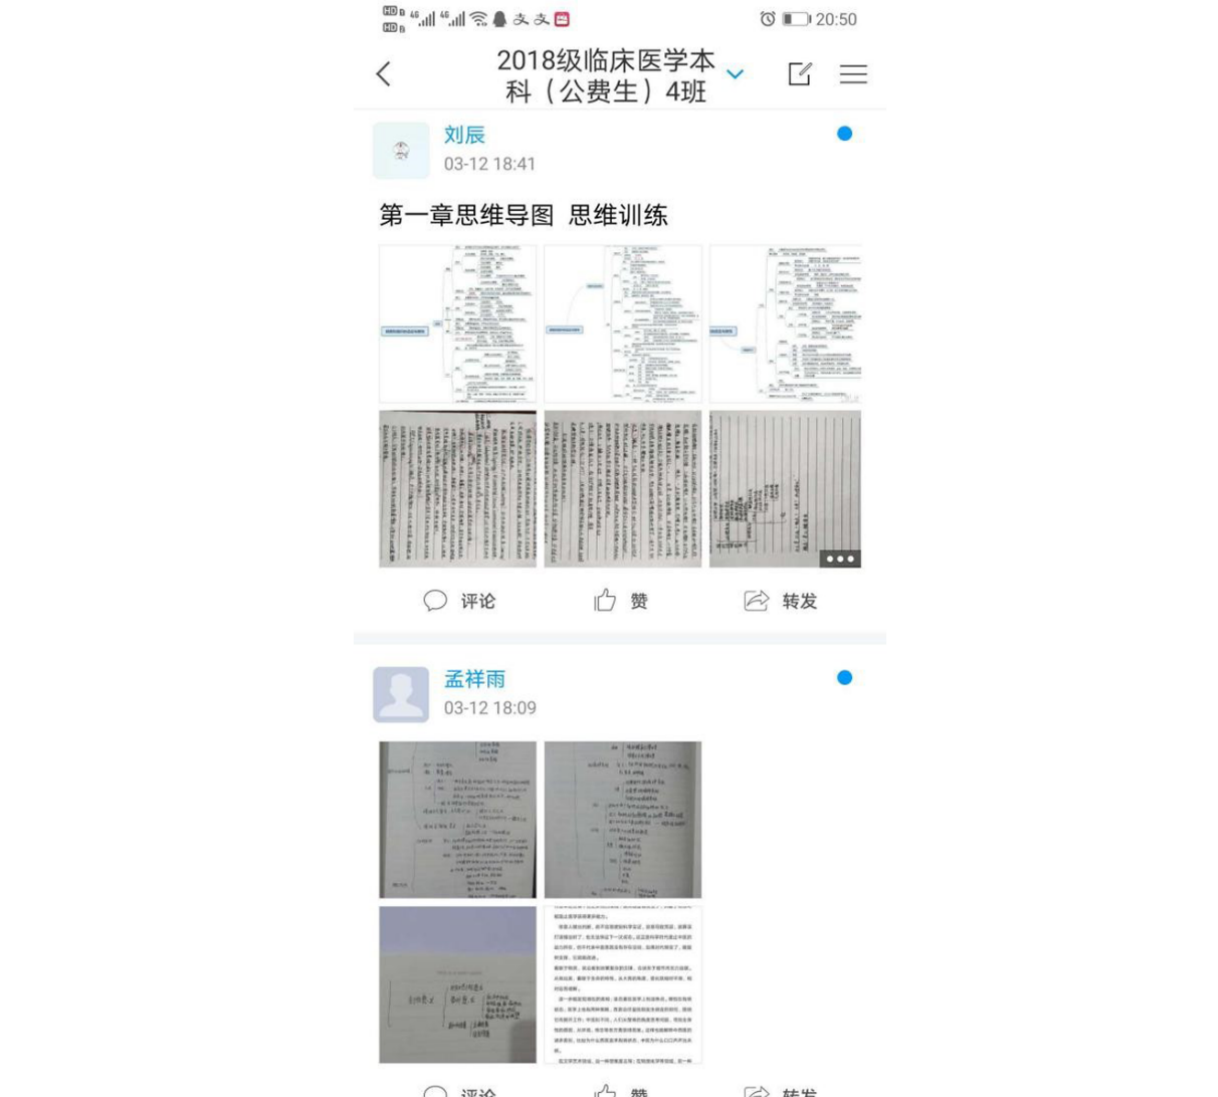
Figure 1. The mind map exercise performed by the